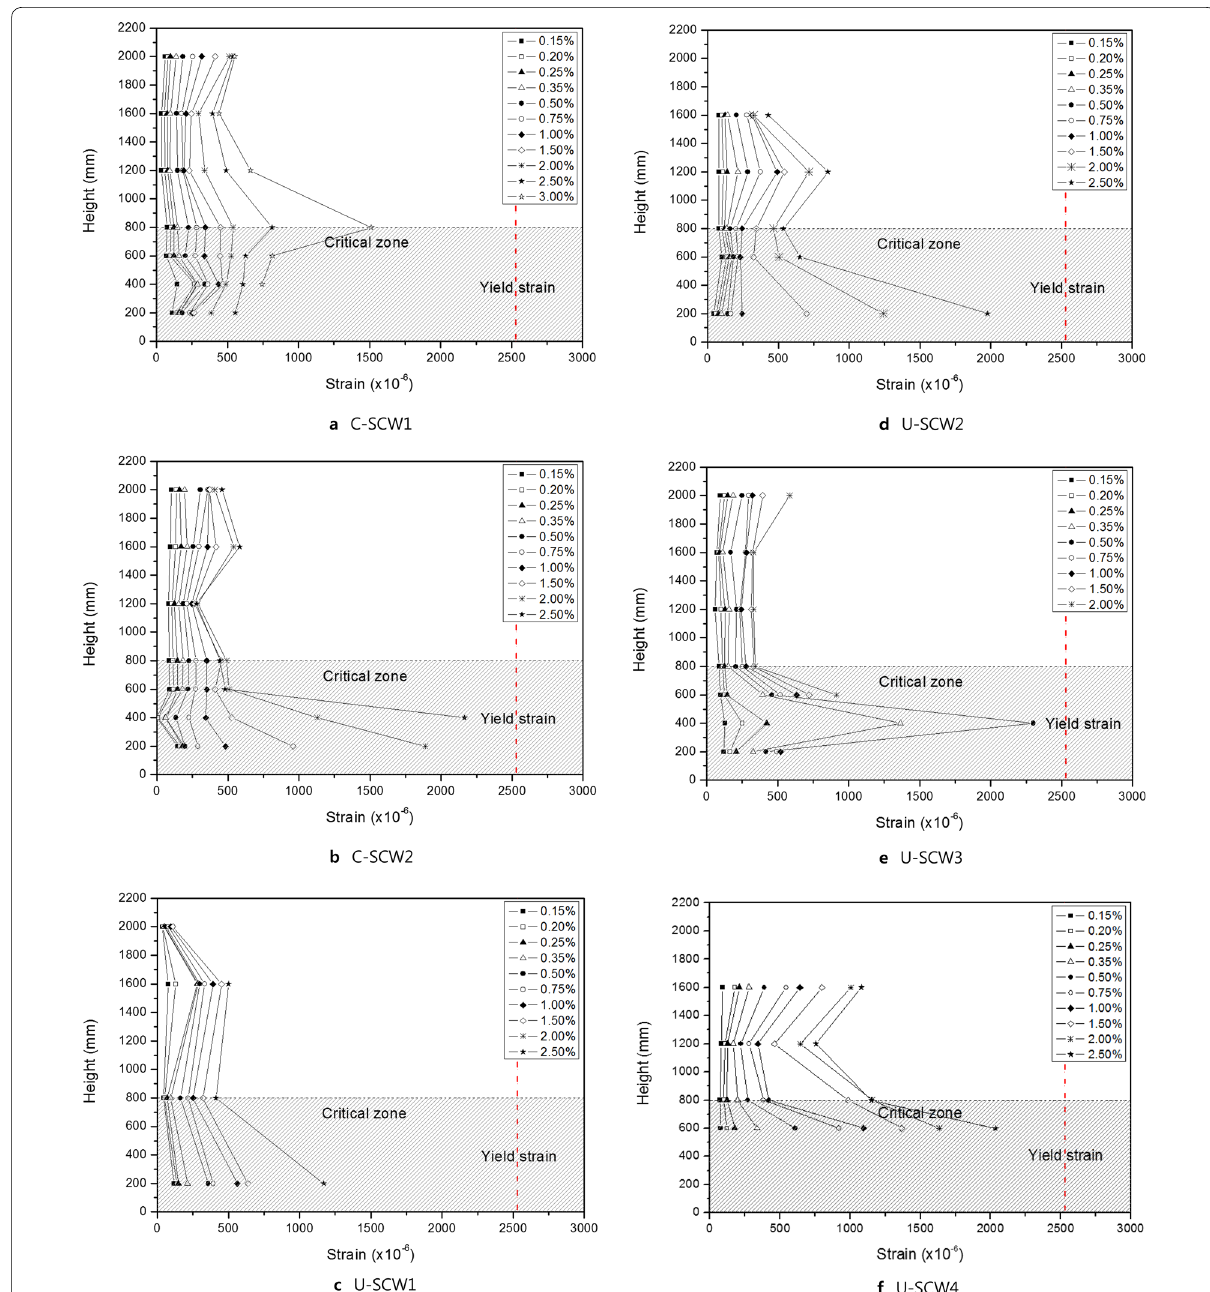
Fig. 18 Strain of transverse